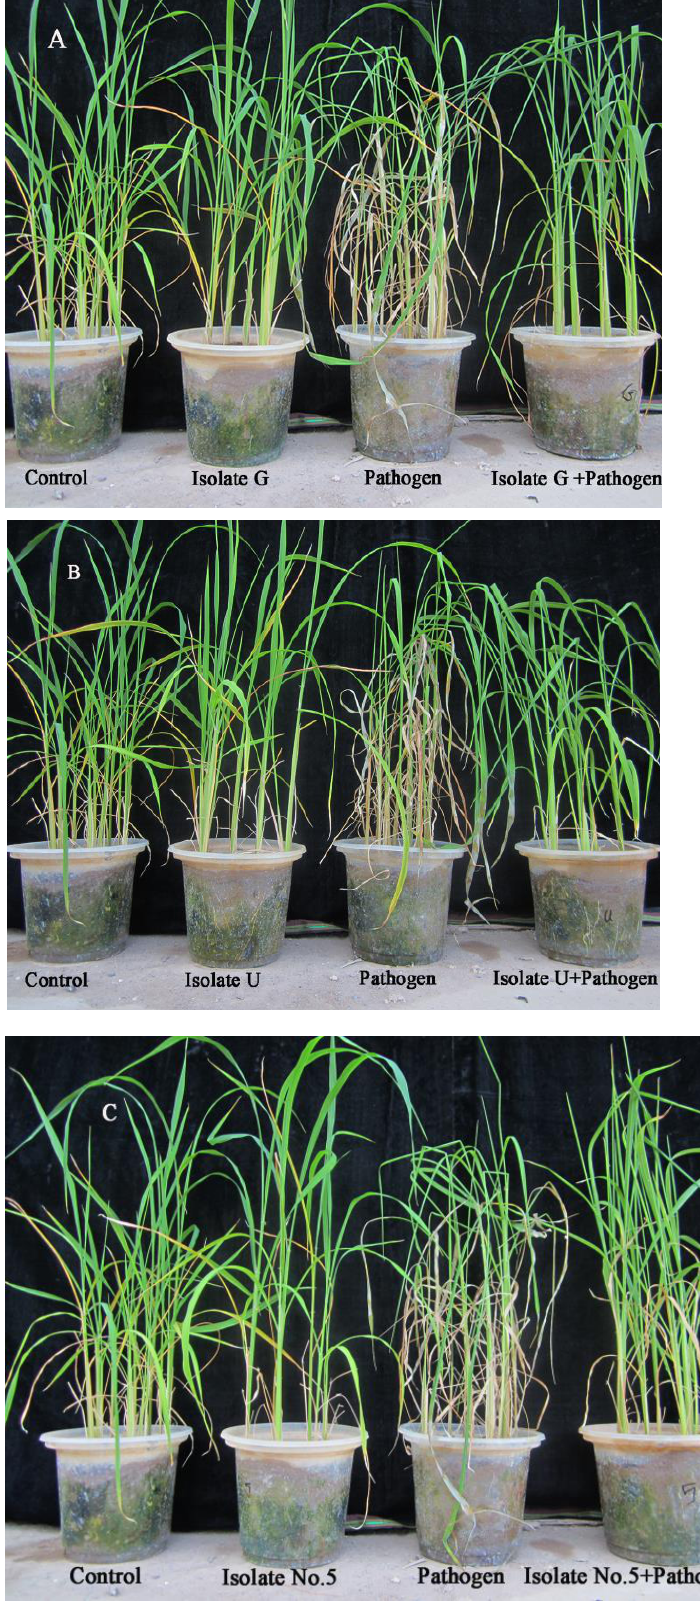
Figure 12. Suppression of sheath blight symptoms in rice leaves by application of Actinomycetes isolates, ( A ) G; ( B ) U, and ( C ) No. 5. isolates, ( A ) G; ( B ) U, and ( C ) No.